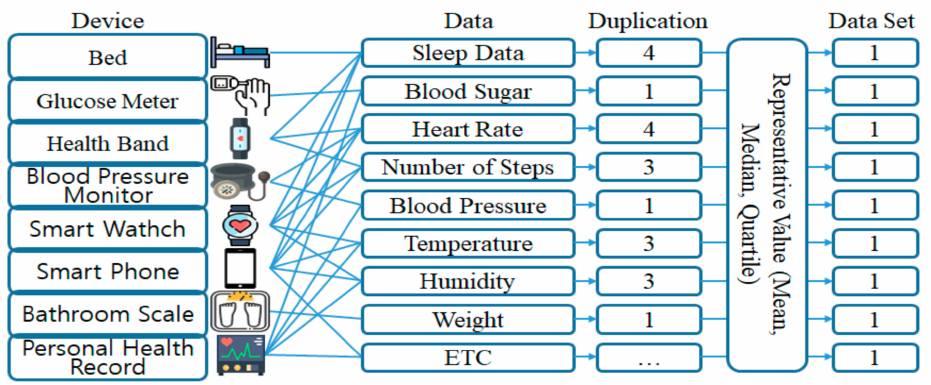
Figure 2. Data duplication of heterogeneous devices.